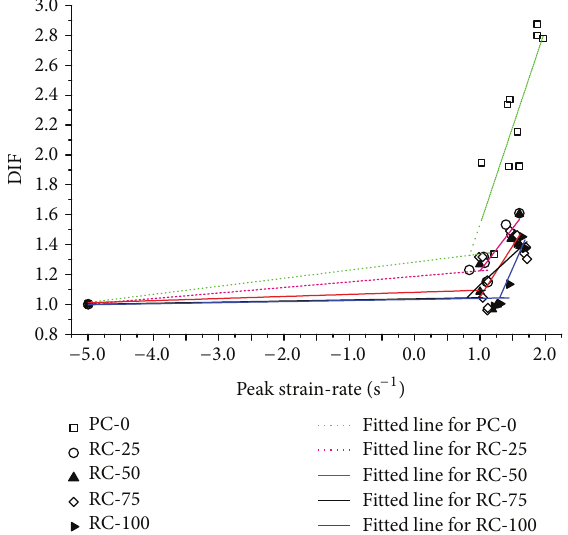
Figure 9: Relationships between DIF and peak strain-rate for RAC